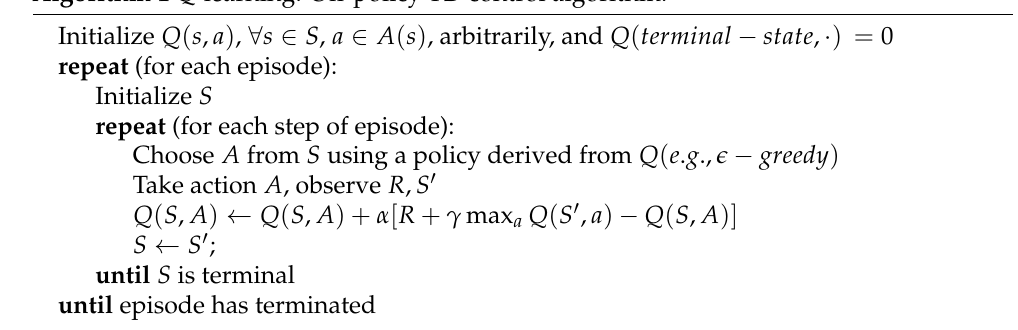
Algorithm 1 Q-learning: Off-policy TD control